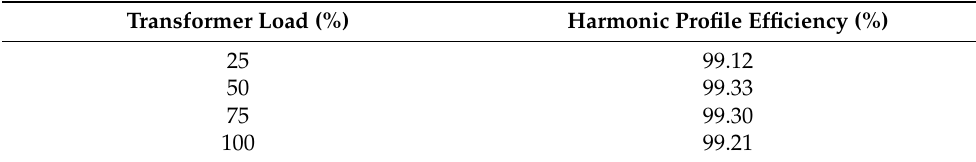
Table 5. Transformer efficiency with harmonic profile calculated.